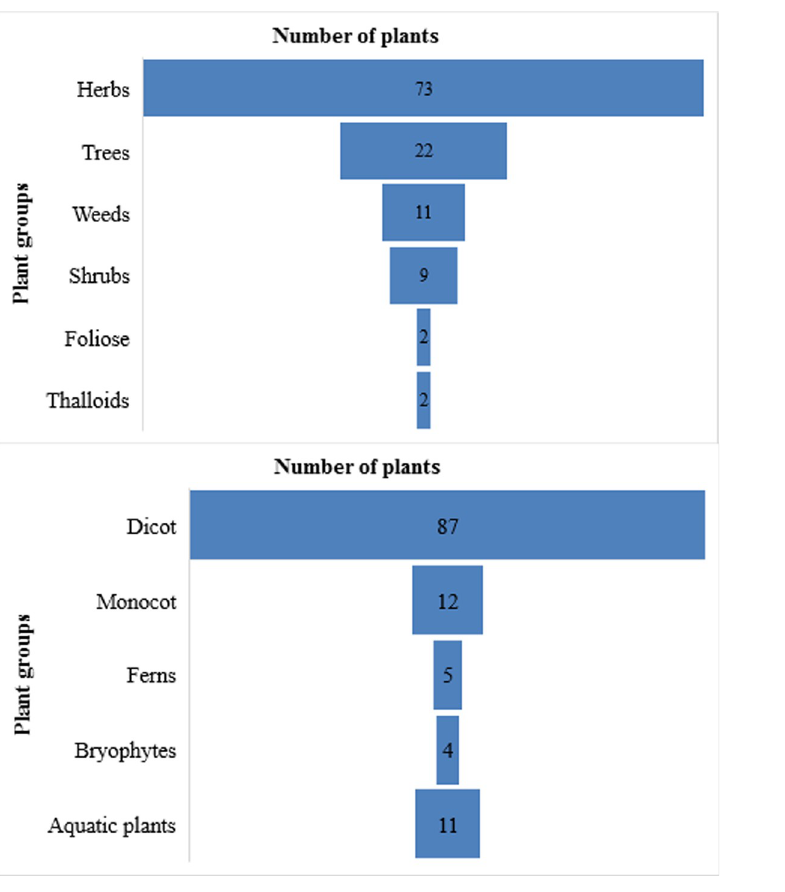
Fig 3. Summary of floral diversity recorded at Head